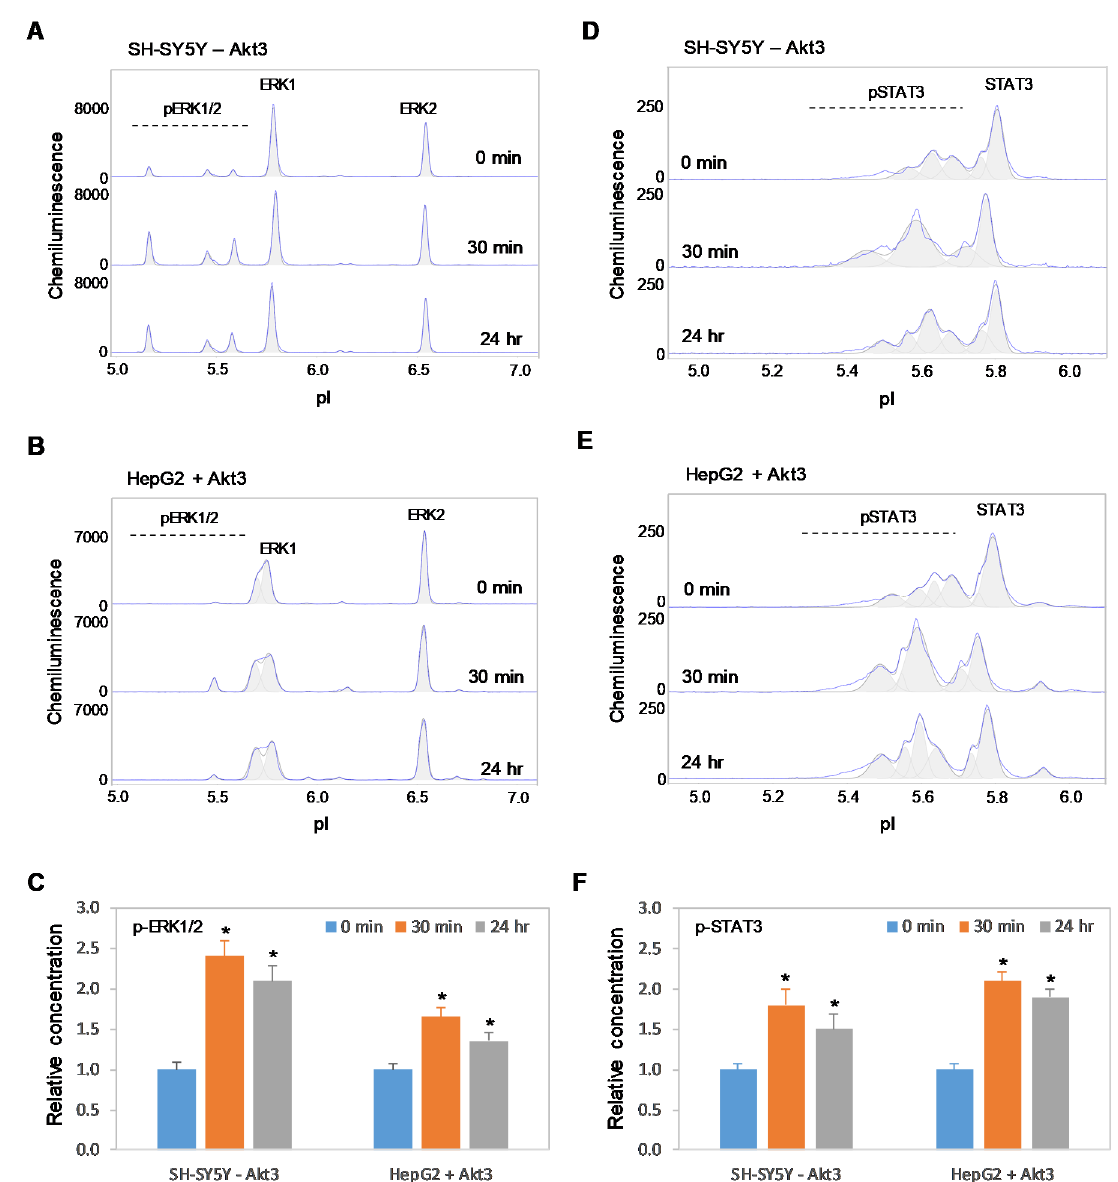
Figure 9. Positive regulation of the MAPK and JAK/STAT signaling pathways by copaiba essential oil is independent of Akt3 expression. ( A , B ) cIEF electropherograms of ERK1/2 in (A) SH-SY5Y cells transfected with siRNA molecules that target Akt3 transcripts and (B) HepG2 cells that express Akt3 from plasmid DNA as a function of time after treatment with copaiba essential oil. ( C ) Relative concentrations of ERK1/2 phosphoisoforms as a function of time after treatment. ( D , E ) cIEF electropherograms of STAT in (D) SH-SY5Y cells transfected with Akt3 siRNA and (E) HepG2 cells transfected with Akt3-encoding plasmid DNA as a function of time after treatment with copaiba essential oil. ( F ) Relative concentrations of STAT3 as a function of time after treatment. The relative concentration describes the fold change in the expression level of a protein phosphoisoform after treatment compared to that under the control condition. The error bars indicate the standard deviations of six repeated measurements per experimental condition. The asterisks indicate a statistical significance of p ≤ 0.05 versus the control. SH-SY5Y and HepG2 cells were treated with 100 ng/mL copaiba essential oil.